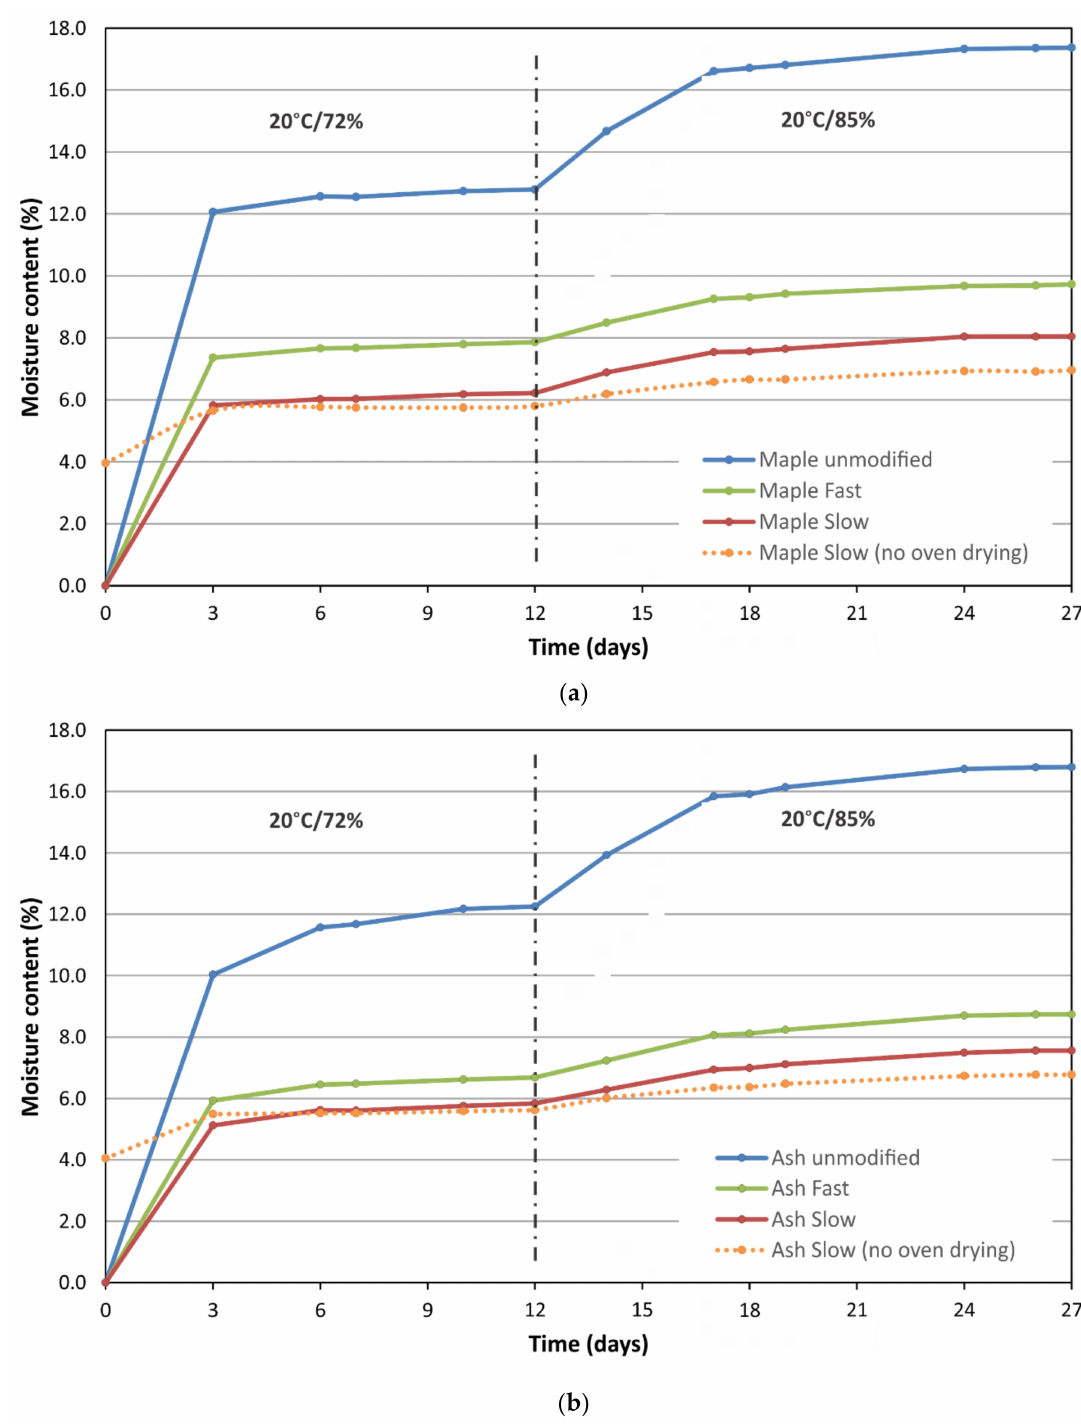
Figure 3. Sorption of Slow and Fast thermally modified wood at two RH values: ( a ) maple; ( b ) ash